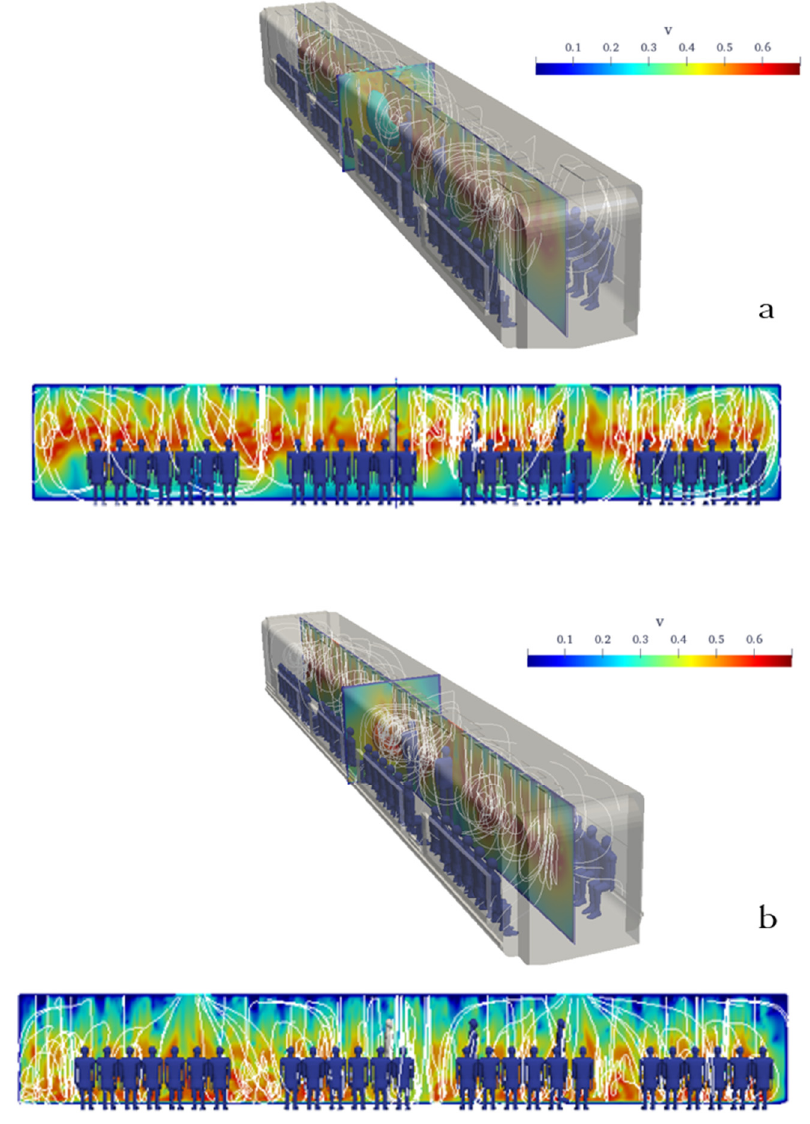
Figure 8. Comparison between the streamlines of a conventional ( a ) and the proposed ( b ) urban subway HVAC systems. The velocity contours shown are in the mid-planes.